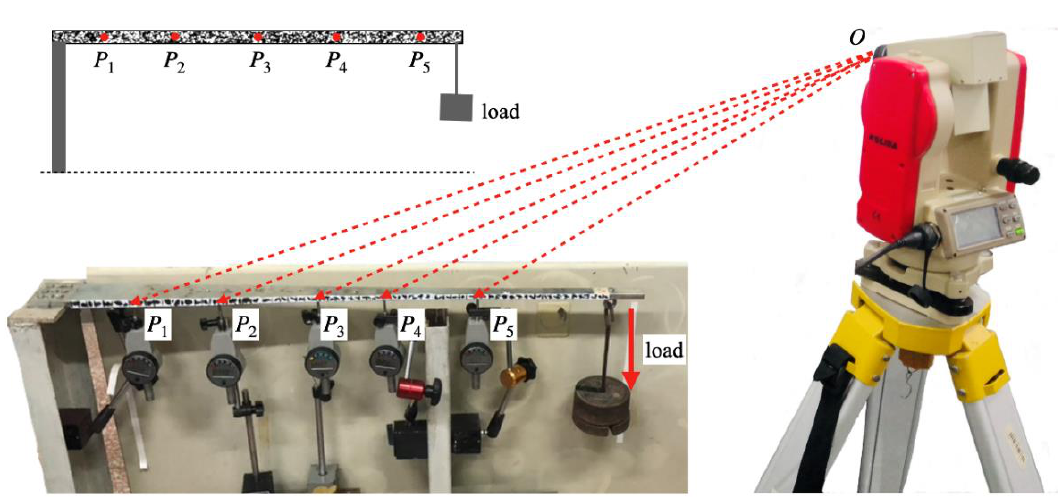
Figure 7. Measurement of a cantilever beam subjected to static loads.